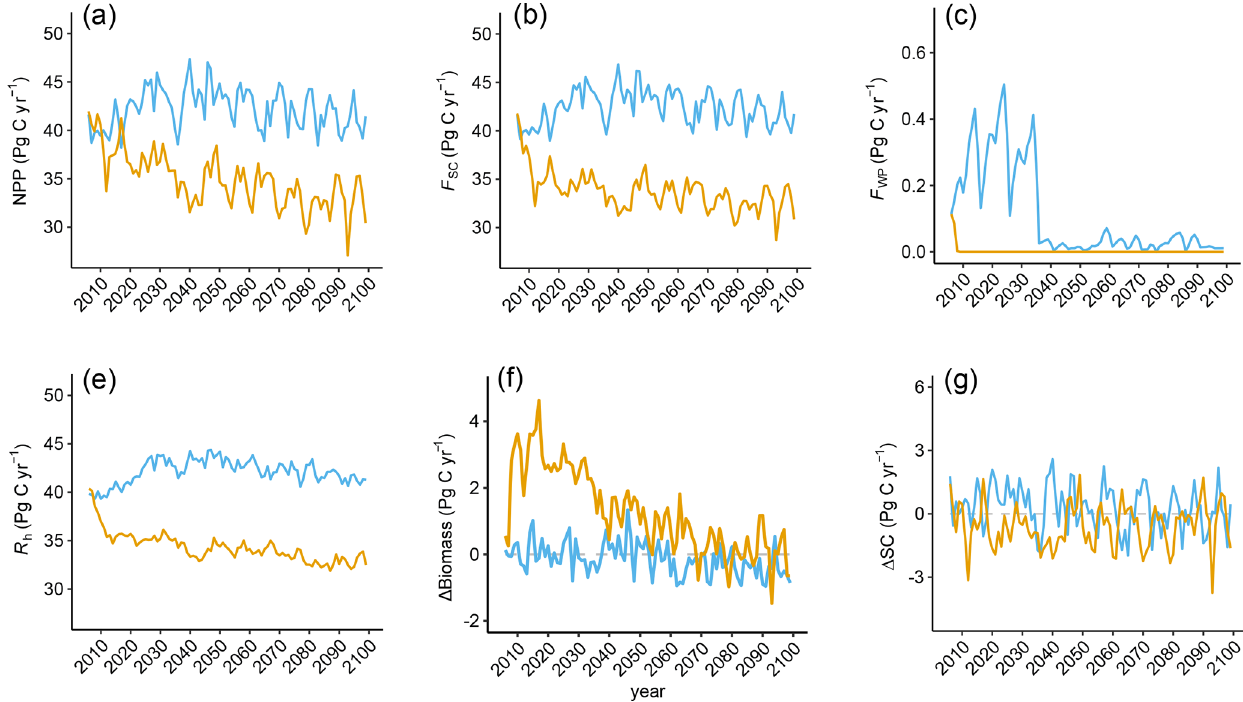
Figure A3. Time series of (a) global net primary production (NPP), (b) global carbon flux into the soil (FSC), (c) global carbon flux into the wood product pools (FWP), (d) global annual change in aboveground biomass ( (cid:49) Biomass), (e) global soil respiration ( R h ), and (f) global annual change in soil carbon ( (cid:49) SC) in the restoration (yellow) and control (blue) simulations.